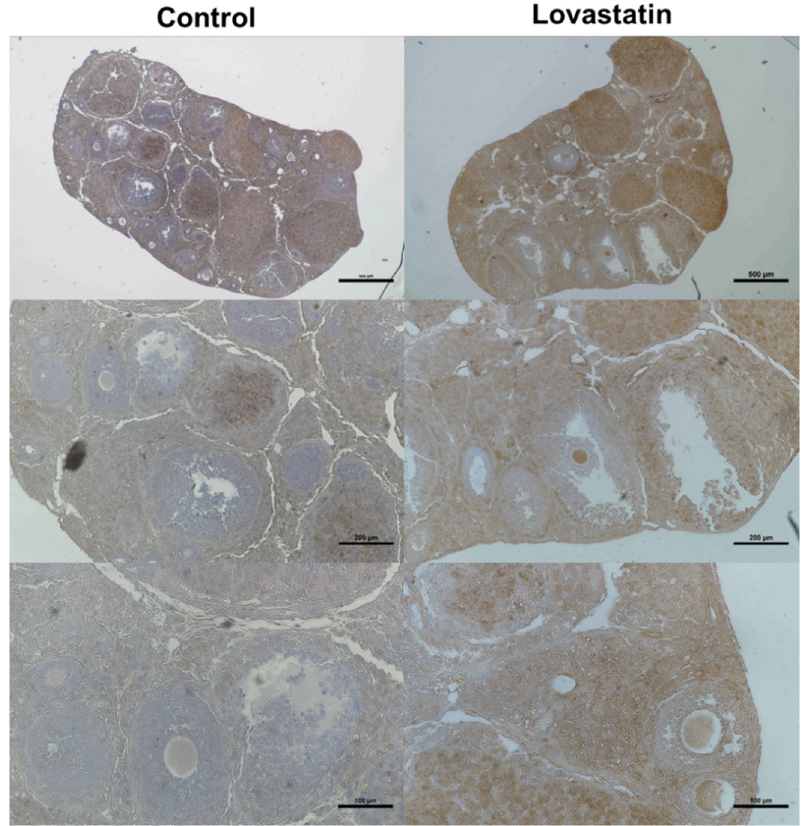
Figure 4. Immunohistochemical analysis of LDLR expression in control and lovastatin-treated ovaries. Right and left panels show lovastatin-treated and control ovaries, respectively, at di ff erent magni fi cations (top: 40×, middle: 100×, and bo tt om: 200×). Scale bars are 500, 200, and 100 µm in the top, middle, and bo tt om panels, respectively ( n = 3).